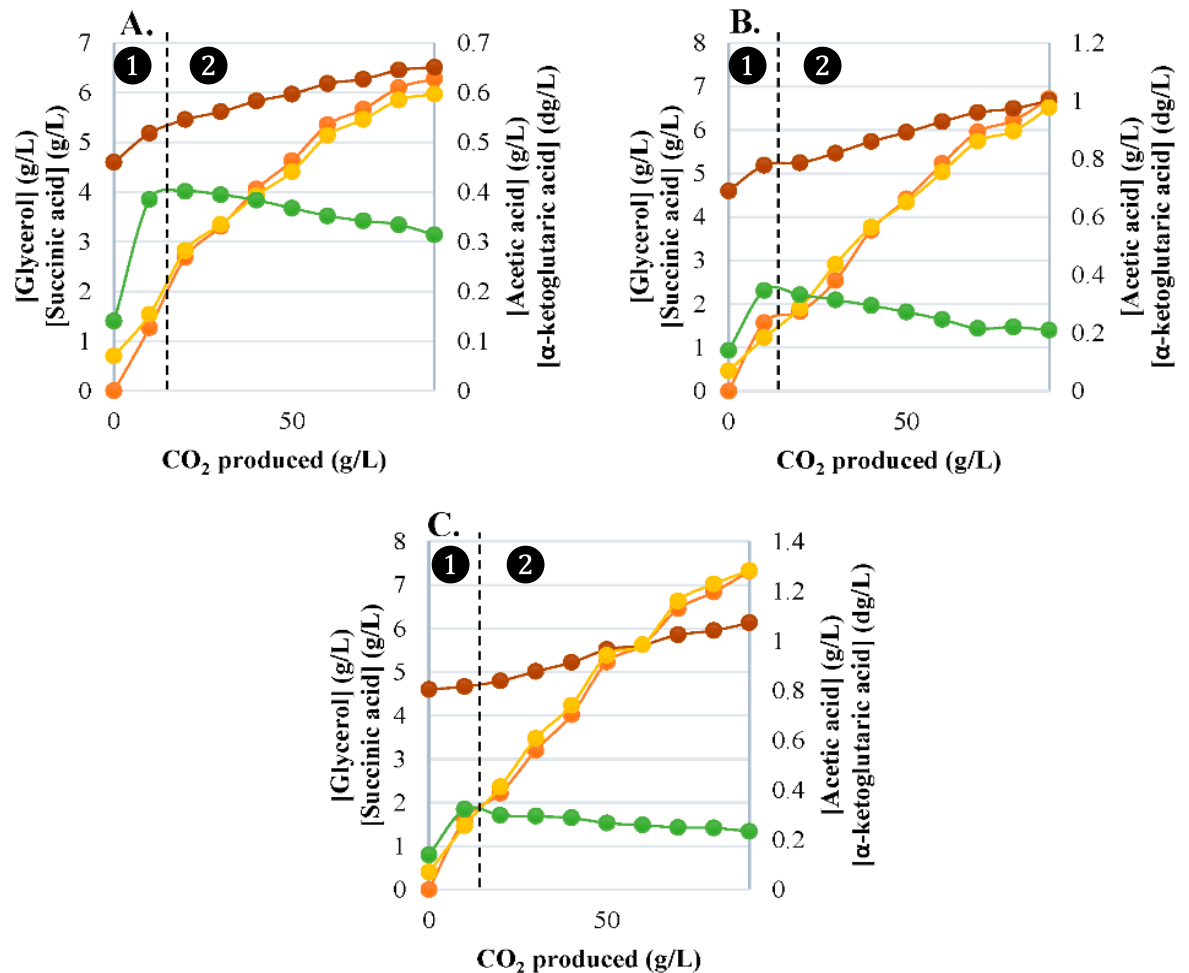
Figure 3. Production kinetics for organic acids at 18 °C ( A ), 24 °C ( B ) and 30 °C ( C ): glycerol (orange), succinate (brown), α -ketoglutarate (yellow) and acetic acid (green). ❶ growth phase and ❷ station- ary phase.